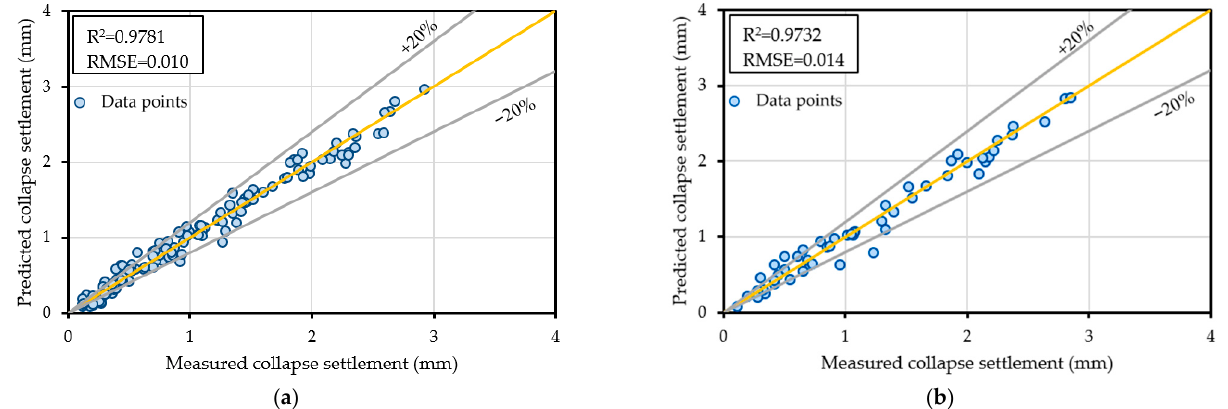
Figure 4. Comparing the results of the predicted and measured collapse settlement based on the secant hyperbolic function. ( a ) Training data, ( b ) Testing data.